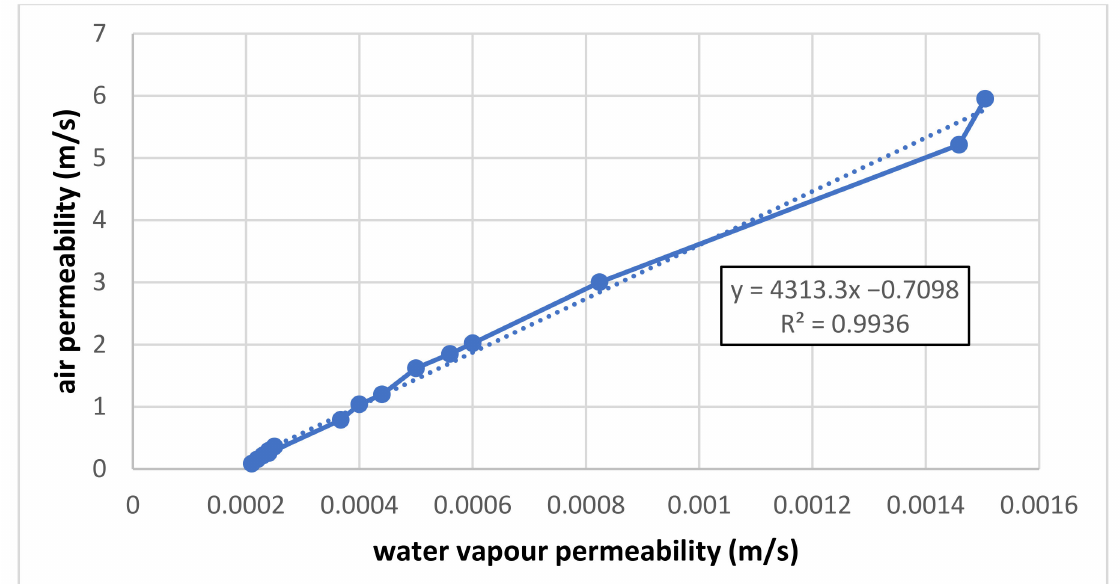
Figure 11. Common graph of linear correlation between air and vapour